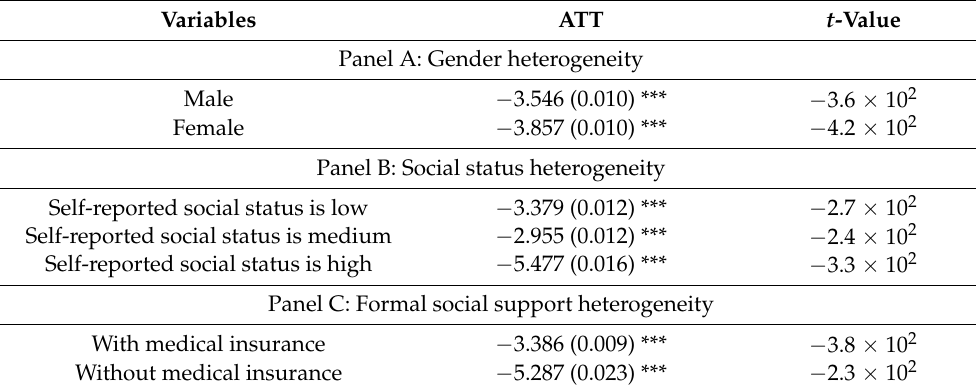
Table 6. The average treatment effects on treated of heterogeneity